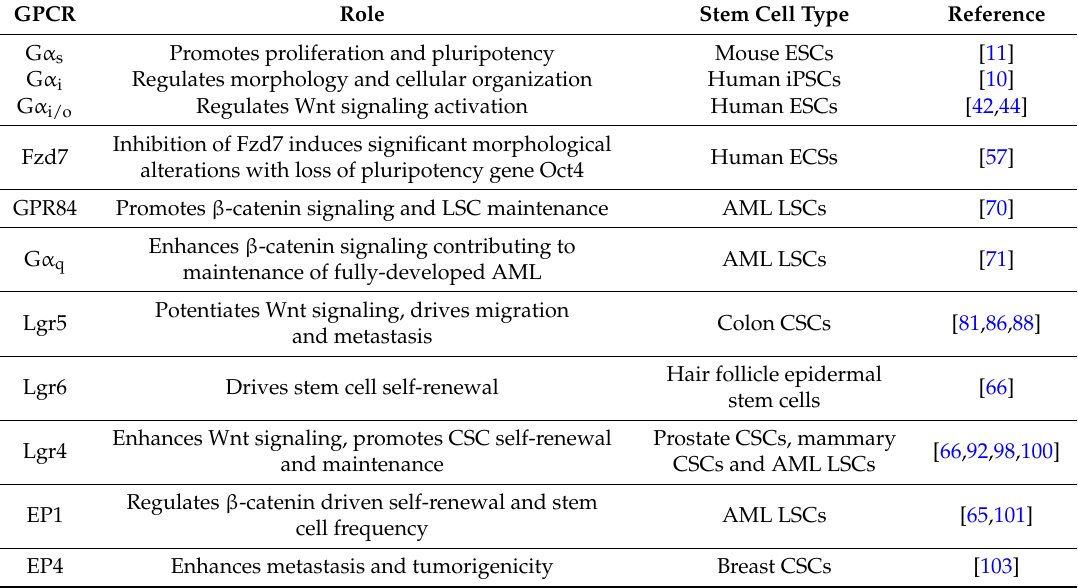
Table 1. The roles of GPCRs in normal and malignant stem cells. The roles of selected GPCRs in functional regulation of both normal and malignant stem cells are listed above.